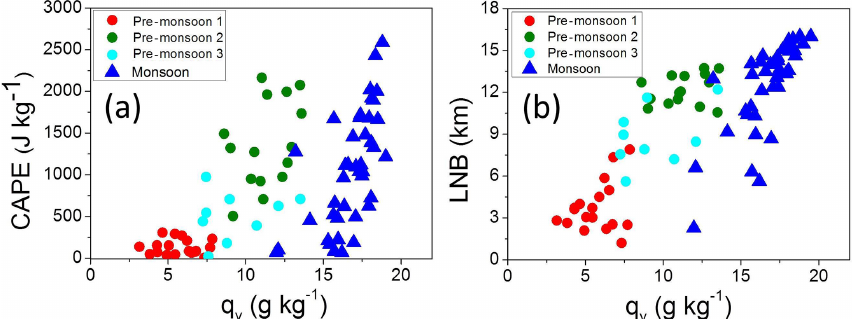
Figure 5. Variation of (a) CAPE and (b) LNB as a function of the surface water vapour mixing ratio. Pre-monsoon cases are grouped similarly as in Fig. 4.